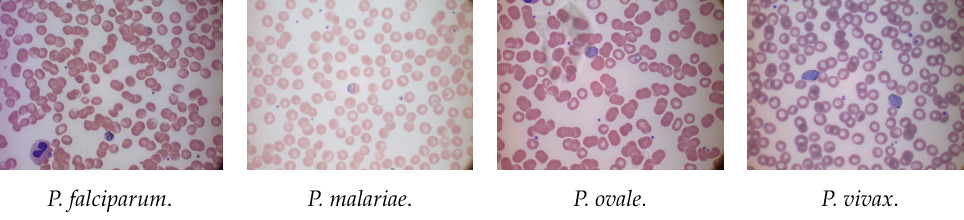
Figure 1. Example of RBCs, healthy ( left ) and sick ( right ), included in the NIH dataset.